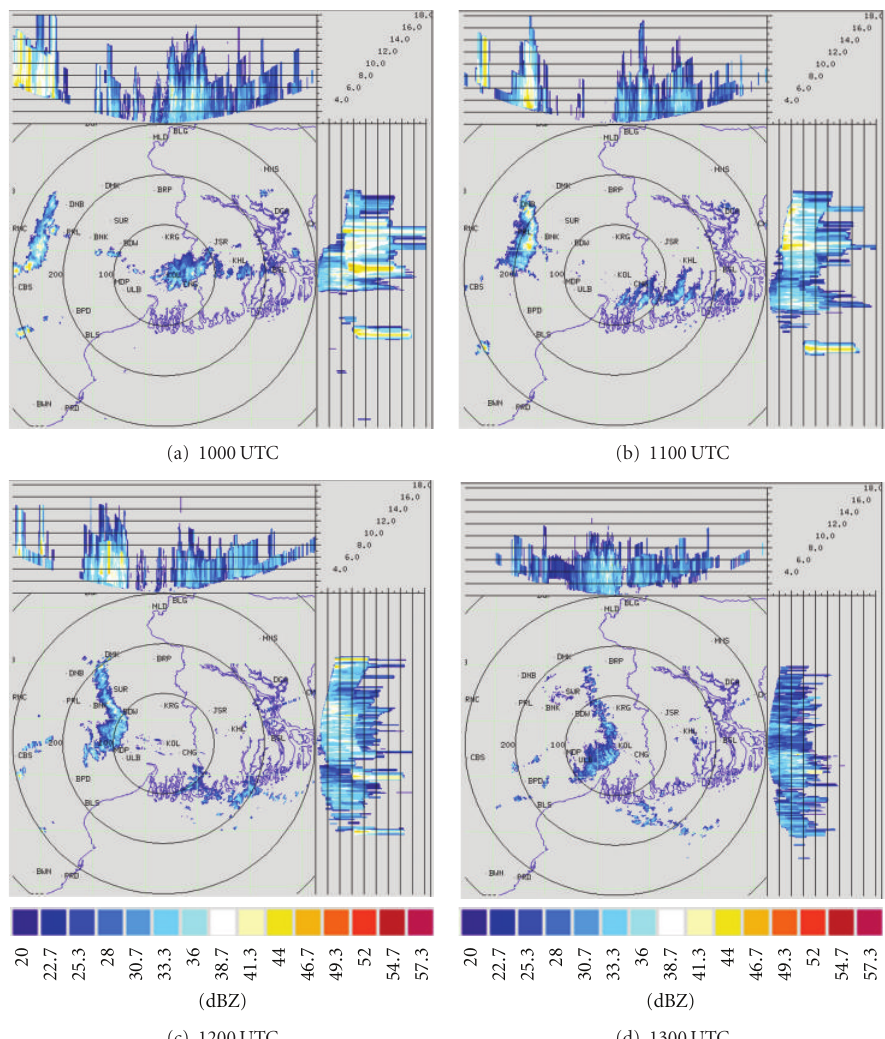
Figure 4: Kolkata Doppler weather radar (DWR) composite radar reflectivity (dBZ) imageries from 1000 to 1300 UTC on 03, May, 2009.